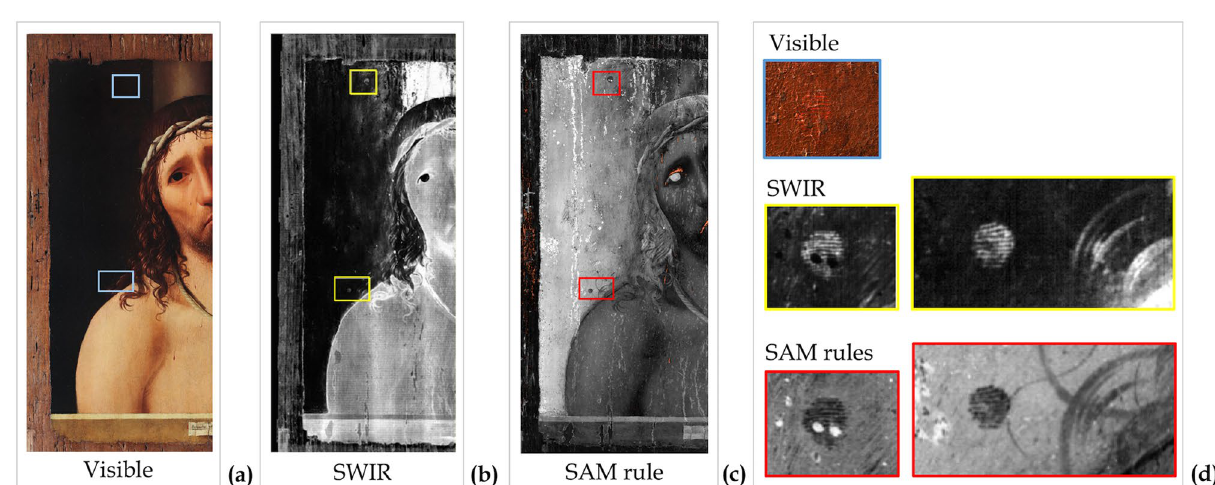
Figure 11. Fingerprints. ( a ) Location of the traces, not visible in the painting. ( b ) Evidence of fingerprints as lighter traces in the image extracted from the short-wave infrared range (SWIR) derivative cube at 1480 nm. ( c ) Evidence of fingerprints as darker traces in the grey-scale spectral angle mapper (SAM) rule of red-lake. ( d ) Magnification of: upper fingerprint in visible macro-photography (photo by Carlo Pagani); upper and lower fingerprints in SWIR and SAM